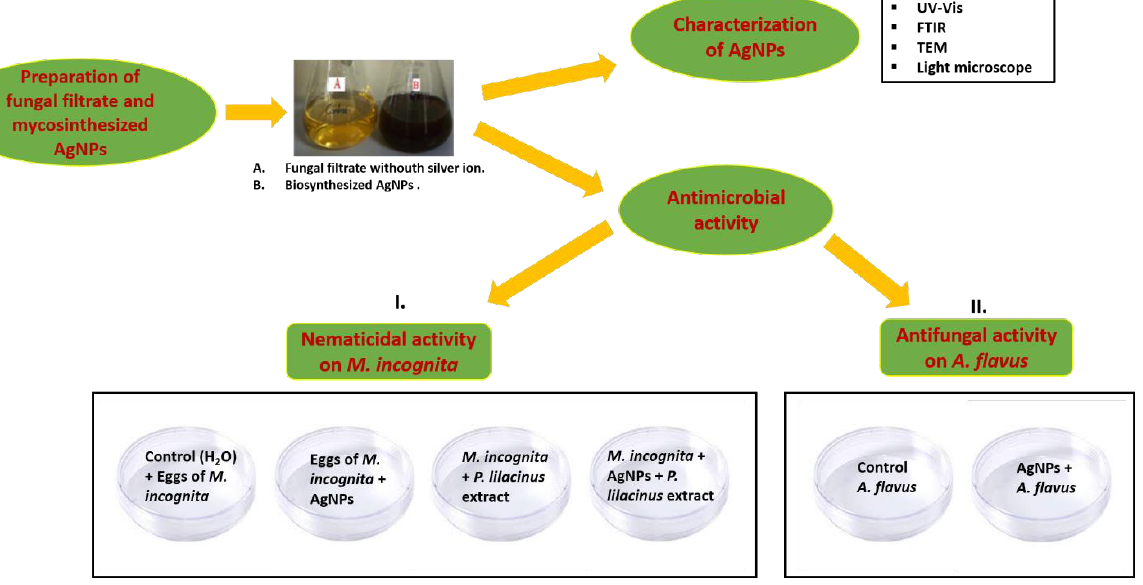
Figure 1. Graphical scheme of study